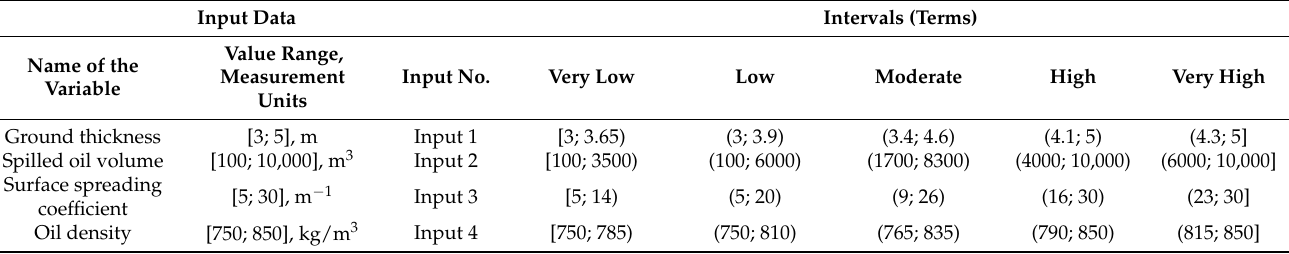
Table 4. Linguistic terms of input data.